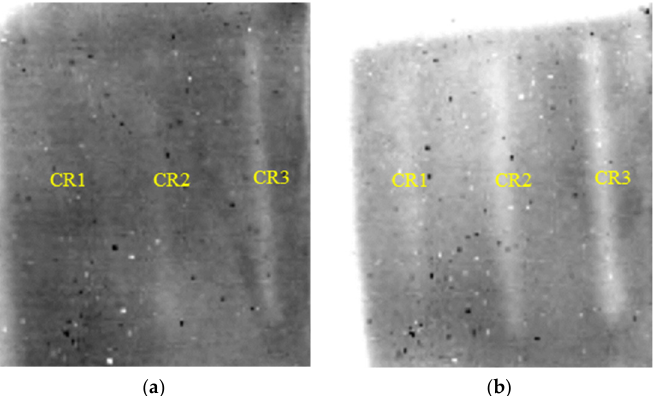
Figure 11. Detection results of cracks in FRP bonded with 5 mm thick SIR. ( a ) The 1114th frame 1st DTI. ( b ) The 2947th frame 2nd DTI.